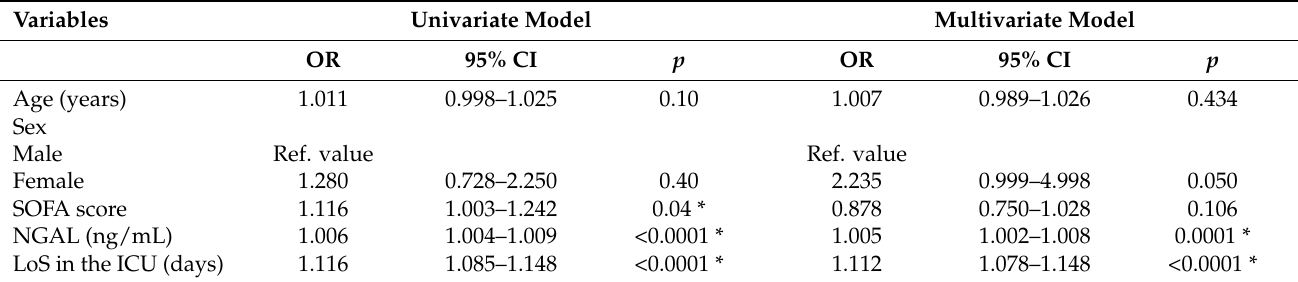
Figure 3. ICU admission biomarker levels and AKI development. Receiver operating character- istic (ROC) curve analysis. ROC curves were generated to determine the prognostic accuracy of either NGAL (solid line), creatinine (dash–dotted line), or their combination (dotted line), as mea- sured at ICU admission (within 24 h). Definition of abbreviations: AKI = Acute kidney injury; NGAL = Neutrophil gelatinase-associated lipocalin. Table 3. Odds ratios and 95% confidence intervals for the possible prognostic factors of AKI